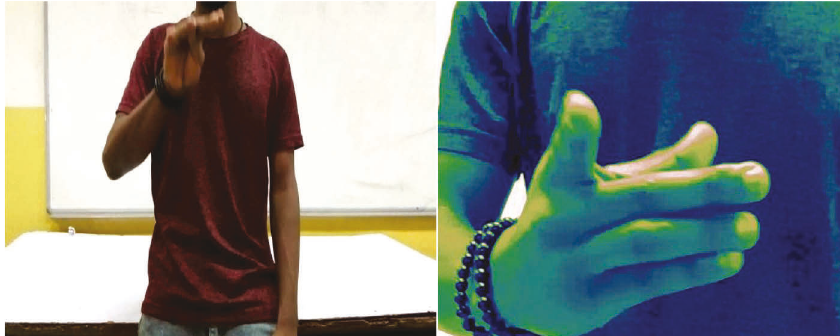
Figure 6: A cropped image of RGB color VS BGR color.